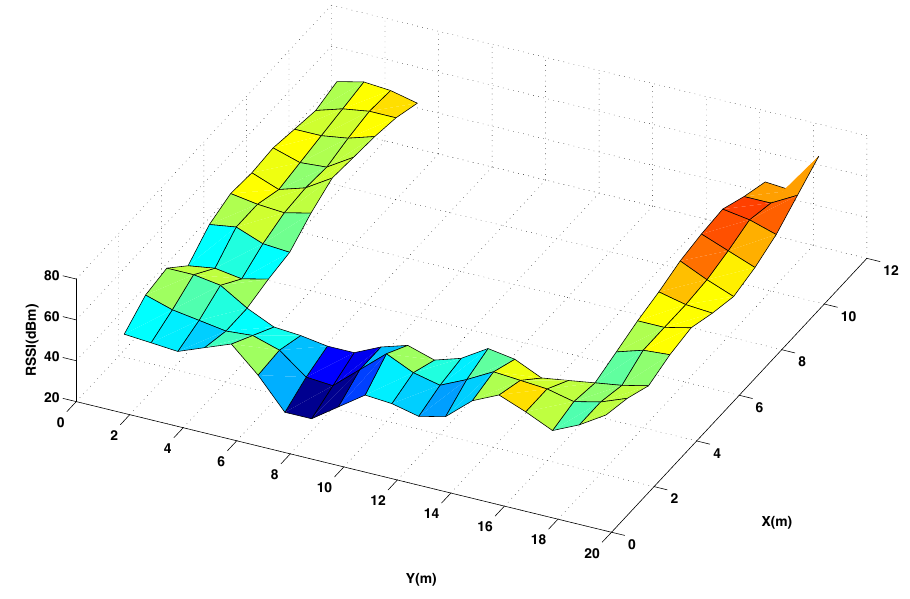
Figure 4. Radio map of RSSI for 50% original and 50% interpolated (using the thin spline function) reference points in the testing area. Using channel CH11 and power level